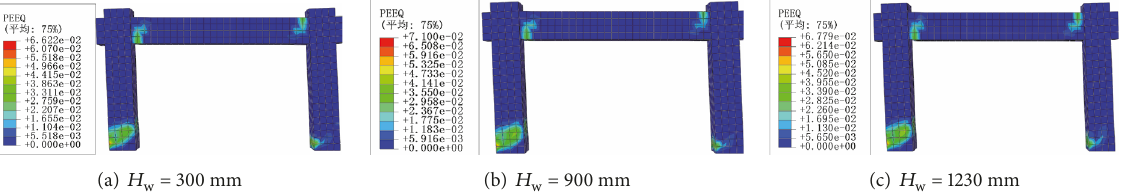
Figure 20: Plastic strain in frames partially infilled with masonry ( 𝑓 m = 2MPa).